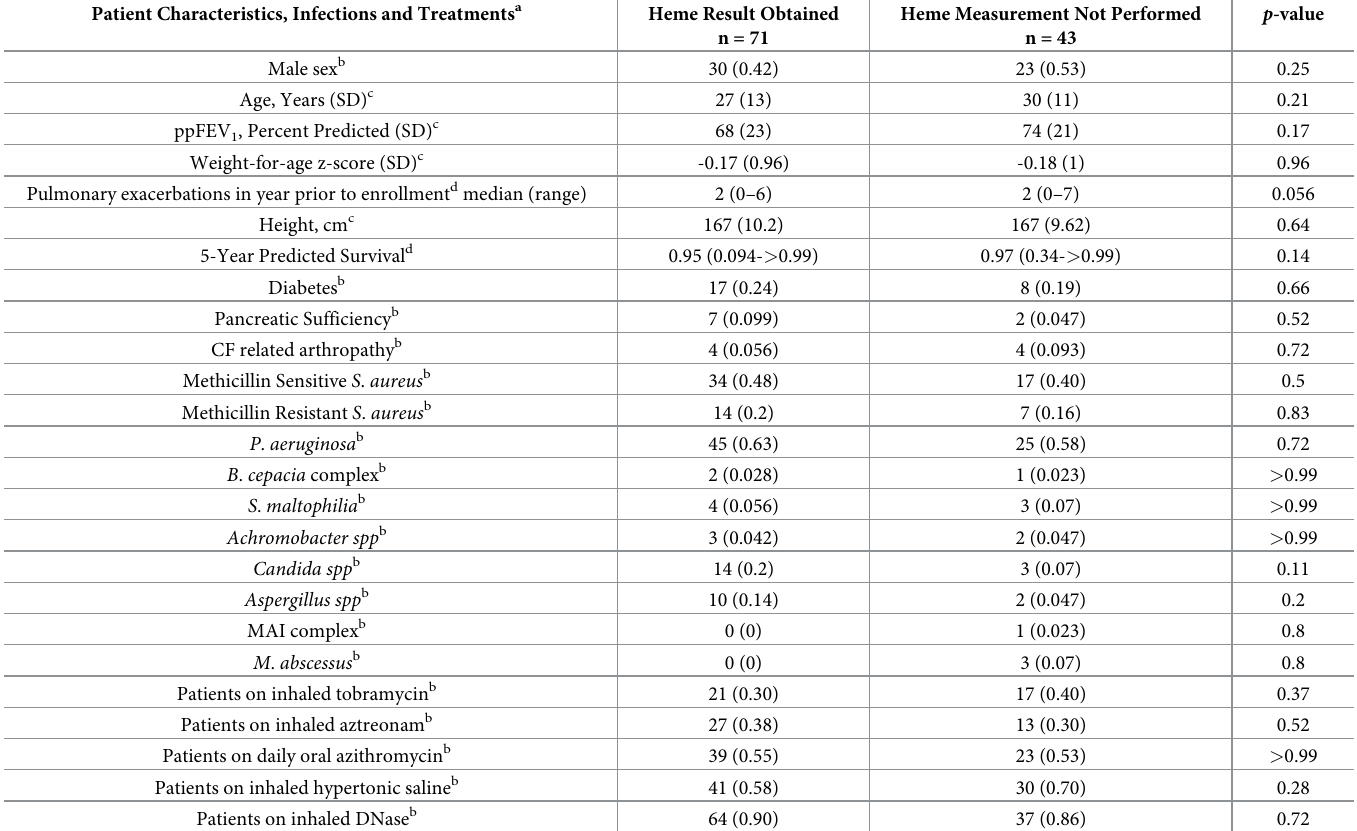
Table 1. Patient cohort characteristics.